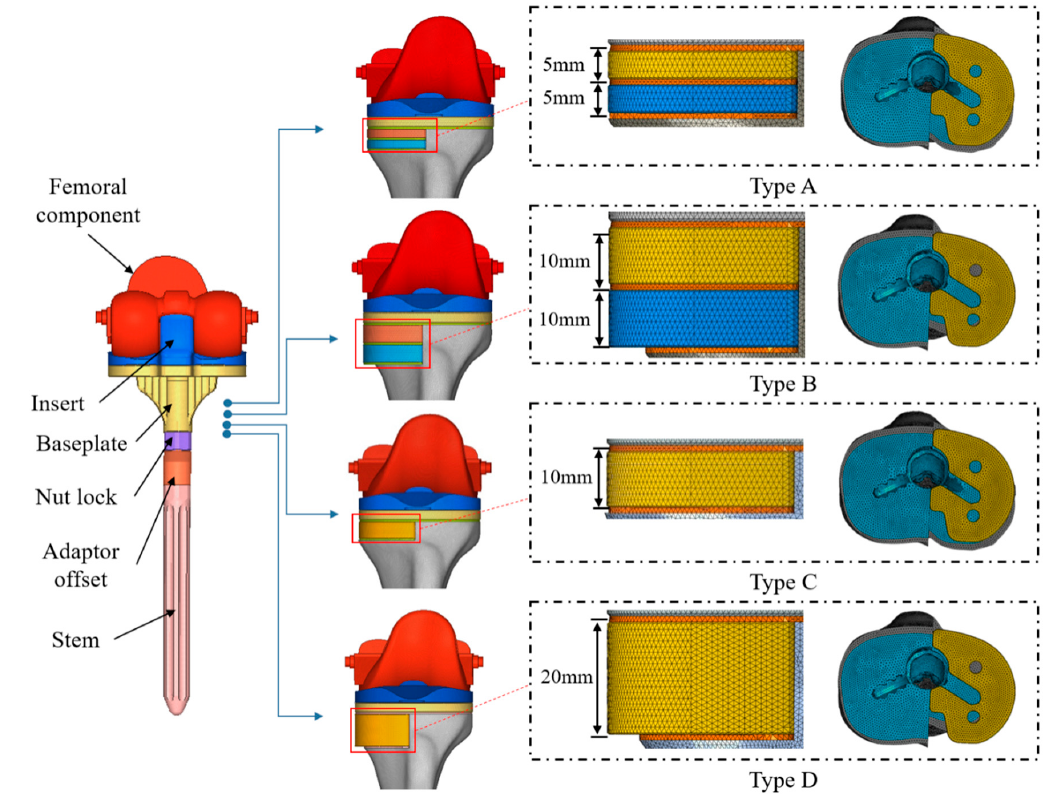
Figure 1. The configurations of the revision TKA with the metal block augmentations for the medium and large uncontained bone defects. Type A: Double metal block augmentation for medium uncontained bone defect, Type B: Double metal block augmentation for large uncontained bone defect, Type C: Single metal block augmentation for medium uncontained bone defect, Type D: Single metal block augmentation for large uncontained bone